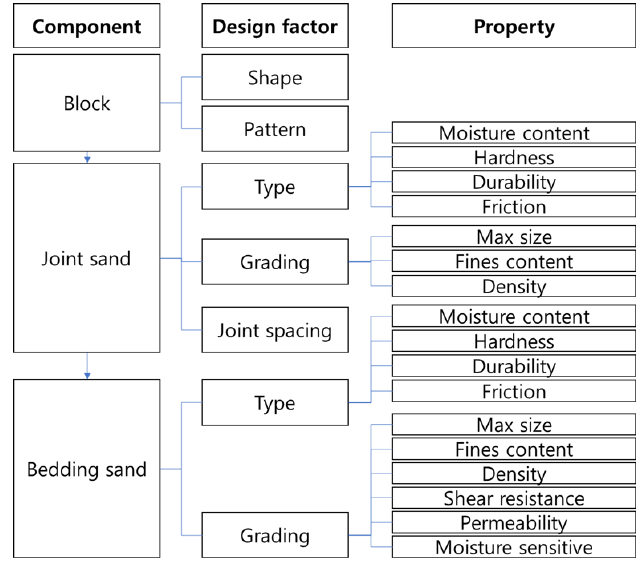
Figure 1. Role and requirements of sand in concrete block pavement design.